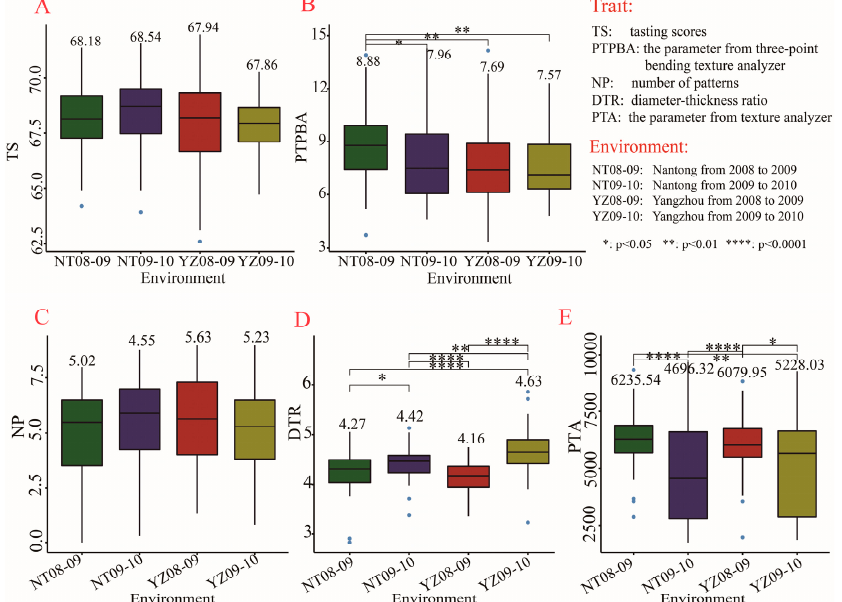
Figure 4. Quality evaluation of Chinese crisp biscuits and American cookies in four growth environments. ( A – E ) Comparison among four growth environments in tasting score ( A ); parameter from three-point bending texture analyzer ( B ); number of patterns ( C ); diameter–thickness ratio ( D ) and parameter of texture analyzer ( E ). Box diagrams present the data in the interquartile ranges. The lines across the boxes, whiskers, and blue circles denote the median values, the 10th and 90th percentiles, and outliers, respectively. The number above the box represents the average level of trait in each environment.